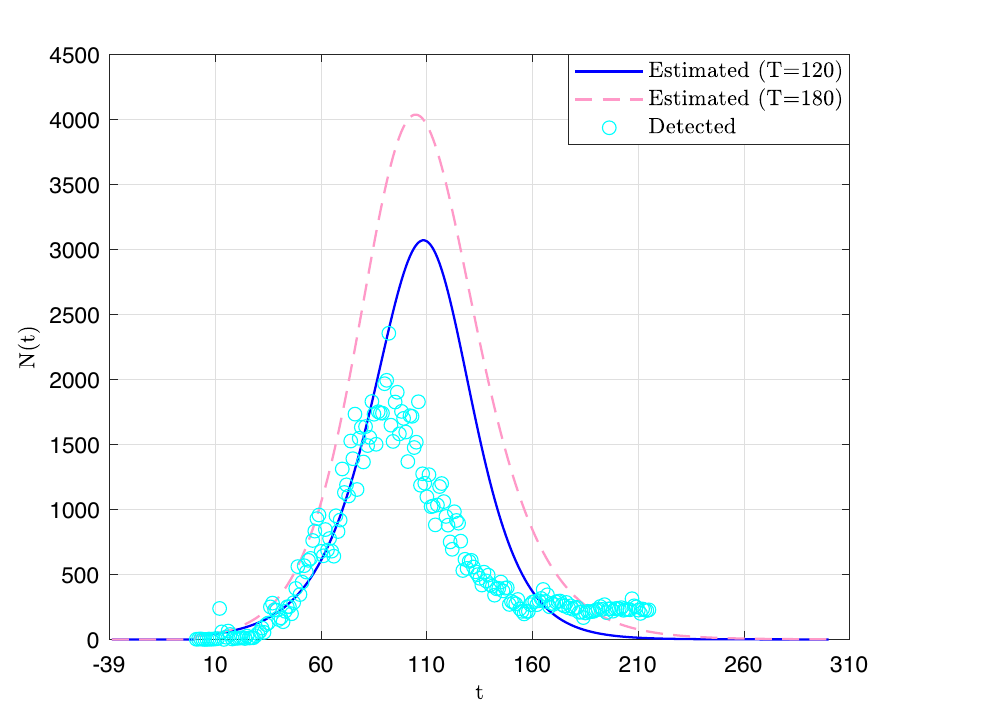
Figure 3. Estimate daily number of infected cases